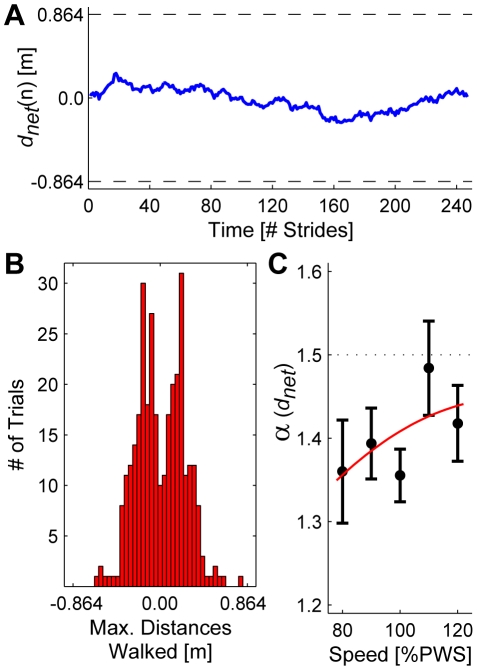
Absolute distances walked on the treadmill.(A) Net cumulative distance, dnet(n), walked (i.e., absolute position, Eq. 6) on the treadmill over time for a typical trial for a typical human subject. Dashed horizontal lines at ±0.864 m indicate the front and back limits of the treadmill belt. All subjects exhibited substantial deviations in absolute position that were sustained across multiple strides, consistent with previous findings [23], [24], [55], [56]. (B) Histogram of maximum rearward (−) and forward (+) distances walked by each subject during each trial at all 5 speeds (166 total trials). Histograms for each individual speed looked similar. Note that most subjects did not get close to reaching the treadmill belt limits (±0.864 m). (C) These stride-to-stride shifts in absolute treadmill position exhibited very strong statistical persistence,approaching that of Brownian motion (i.e., integrated white noise: α = 1.5), particularly at the faster walking speeds. Thus, these deviations in absolute position were not tightly controlled. Note: the vertical scale here is quite different from Fig. 3G–I. The quadratic trend line is shown only to provide a visual reference.